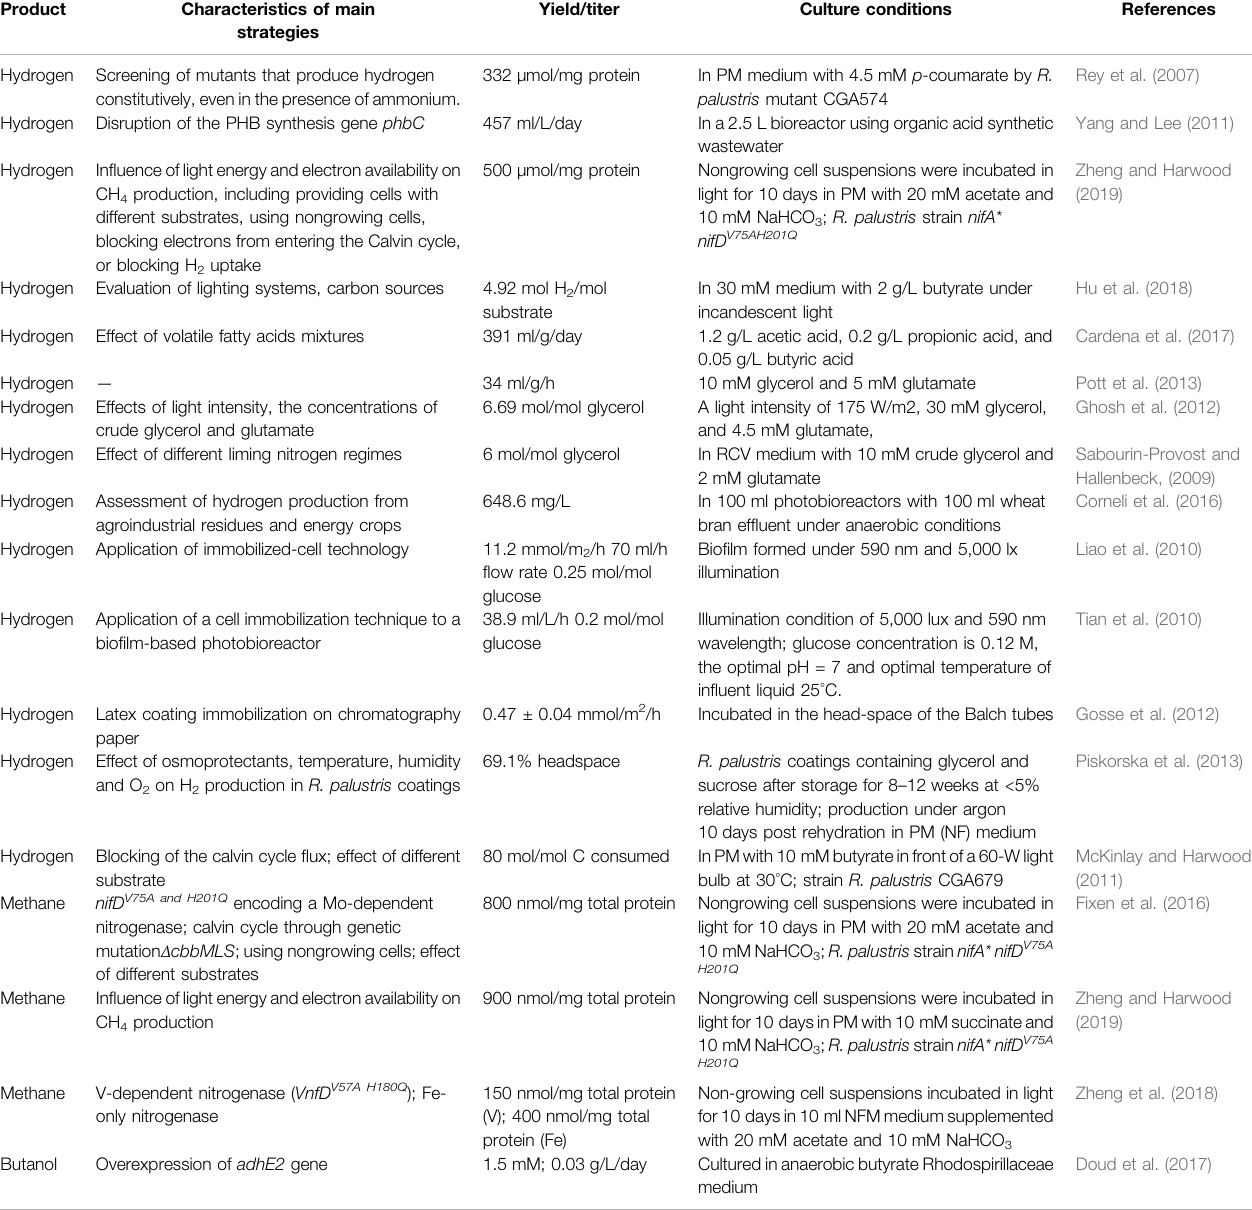
TABLE 3 | Summary of biofuels production in R. palustris